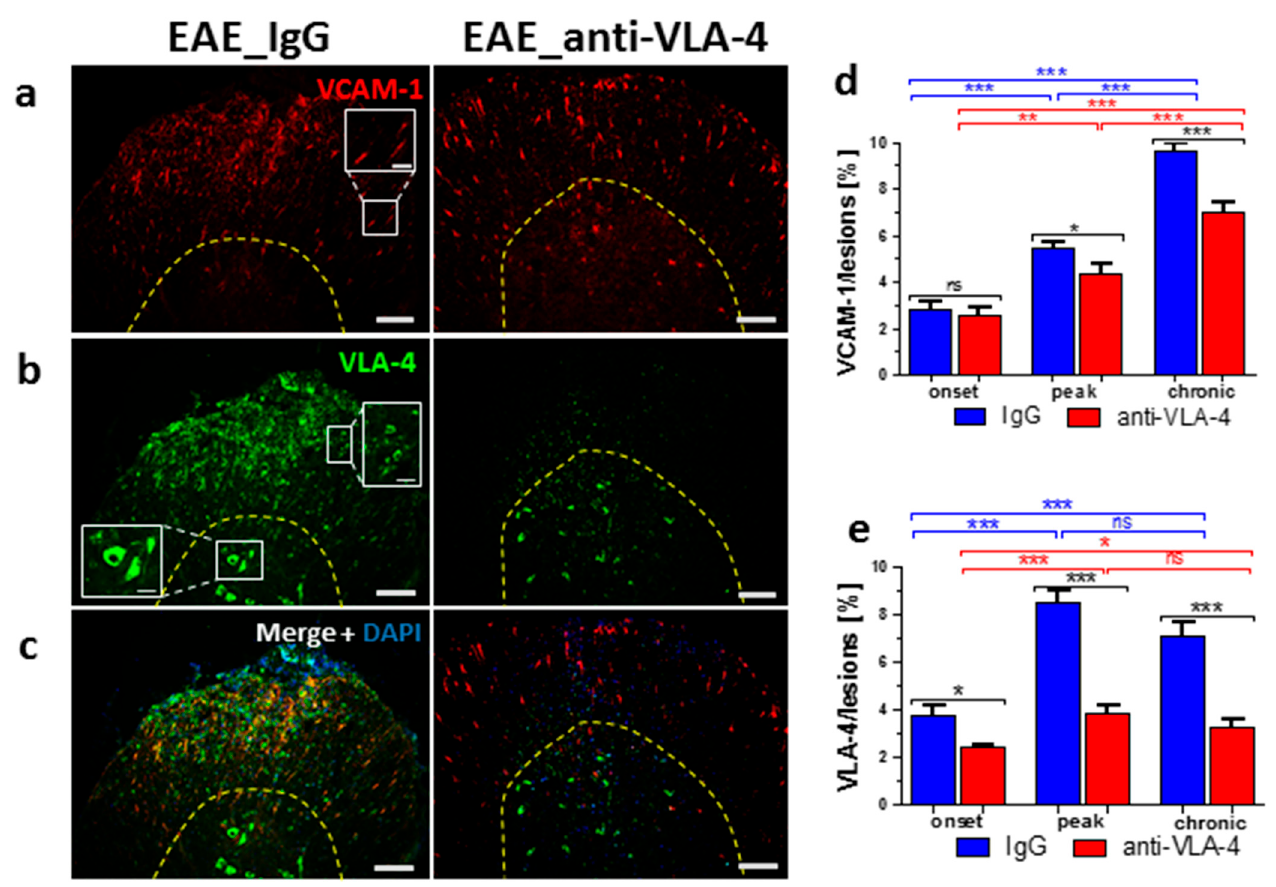
Figure 4. Immunostaining of VCAM-1 ( a ), VLA-4 ( b ) and overlapping fluorescence with DAPI ( c ) in cross-sectioned spinal cords of IgG- and anti-VLA-4-treated mice in the peak phase of EAE, as well as their quantitative measurements. VCAM-1 and VLA-4 expression was quantified as percentage of lesion area occupied by immunofluorescent structures ( d , e ). VCAM-1 is mainly localized in capillaries ( a , inset), and localization of VLA-4 is associated with inflammatory cells in white matter ( b , inset) and in some neuron-like cells in gray matter ( b , inset). Data are presented as means ± SEM; n = 5 per group; nf—not found. Statistical significance was verified using a two-sided Mann–Whitney test at 0.05 confidence level (*** p < 0.001; ** p < 0.01; * p < 0.05; ns—not significant). Magnification is indicated by scale bars (( a – c ) = 100 µm; insets = 25 µm).